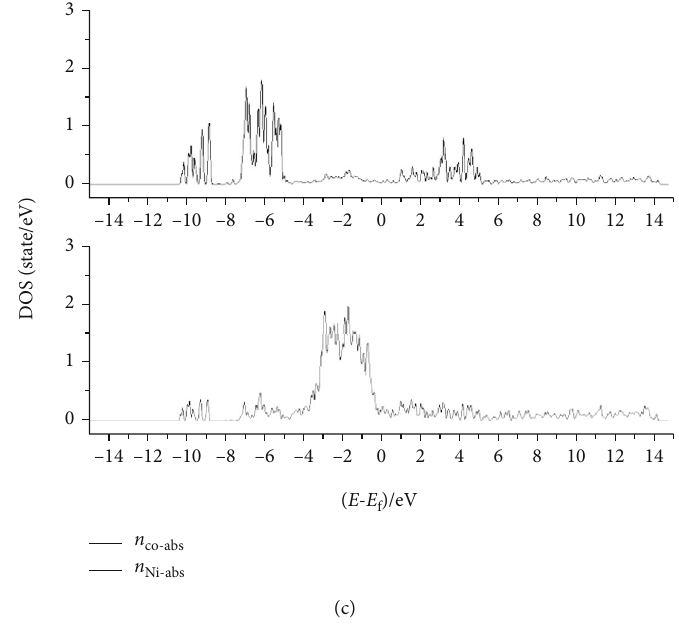
Figure 2: DOS of Ni atom and CO molecule with di ff erent coverages: (a) 33%; (b) 50%; (c)